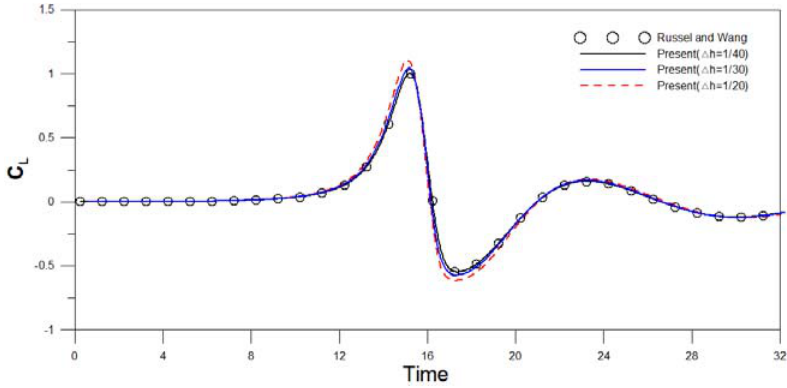
Figure 6. Comparisons of lift coefficient on the upper cylinder at Re = 40.